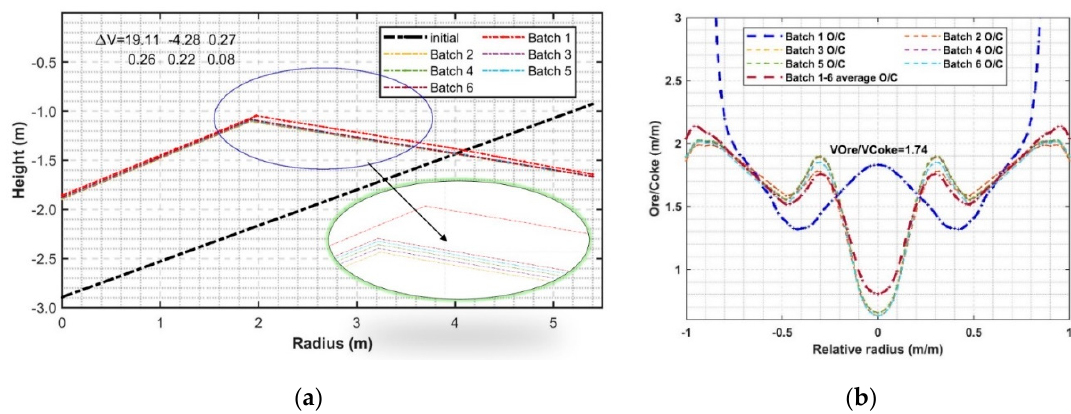
Figure 7. Evolution of ( a ) the burden top surface after the ore dump and ( b ) the distribution of the ore/coke layer thickness ratio for the six batches during the charging process for Case A1c.